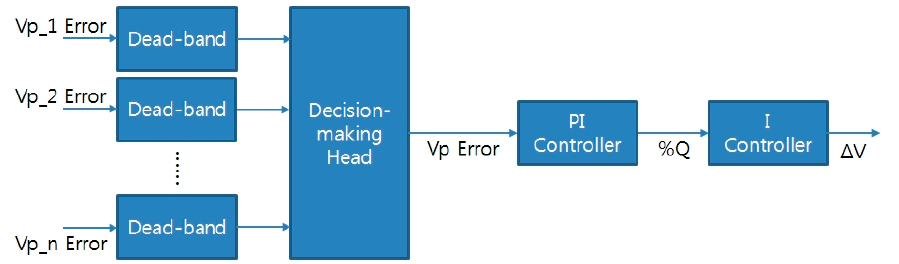
Figure 3. Architecture of the control algorithm.